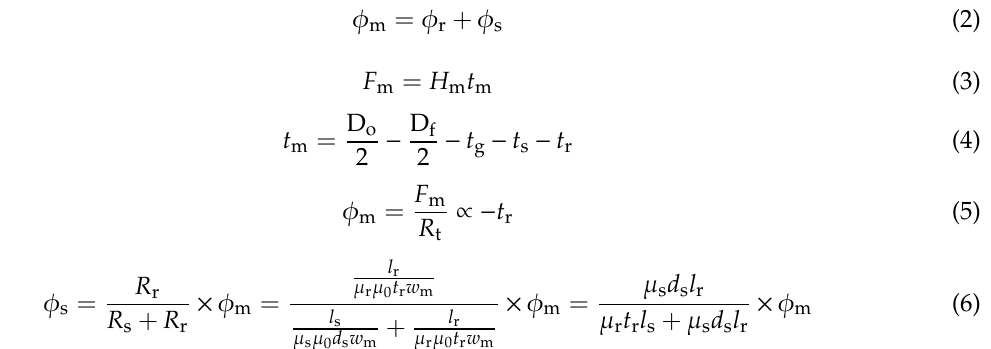
Figure 14. Ring motor magnetic